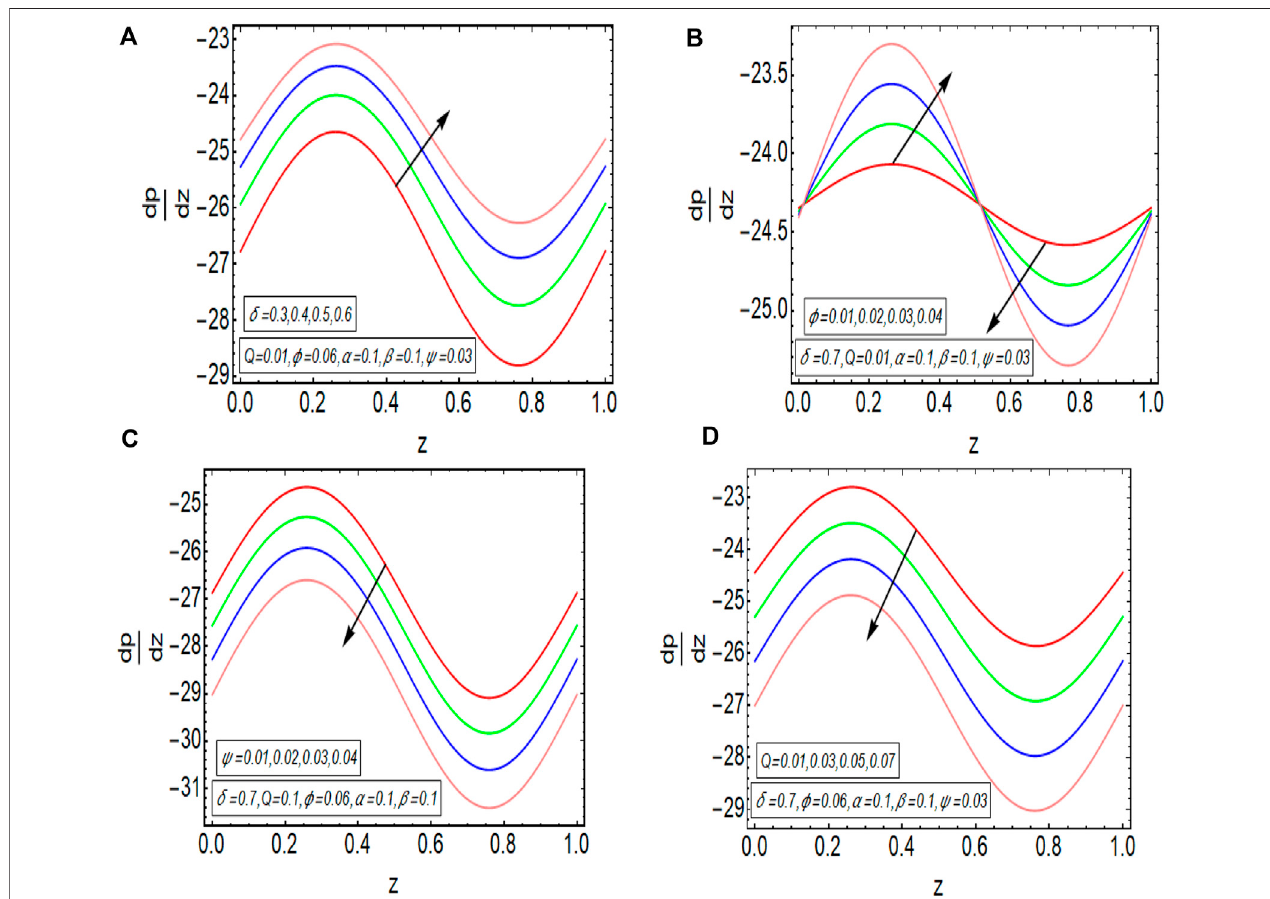
plot against axial coordinate for occulsion . (C) dp dz